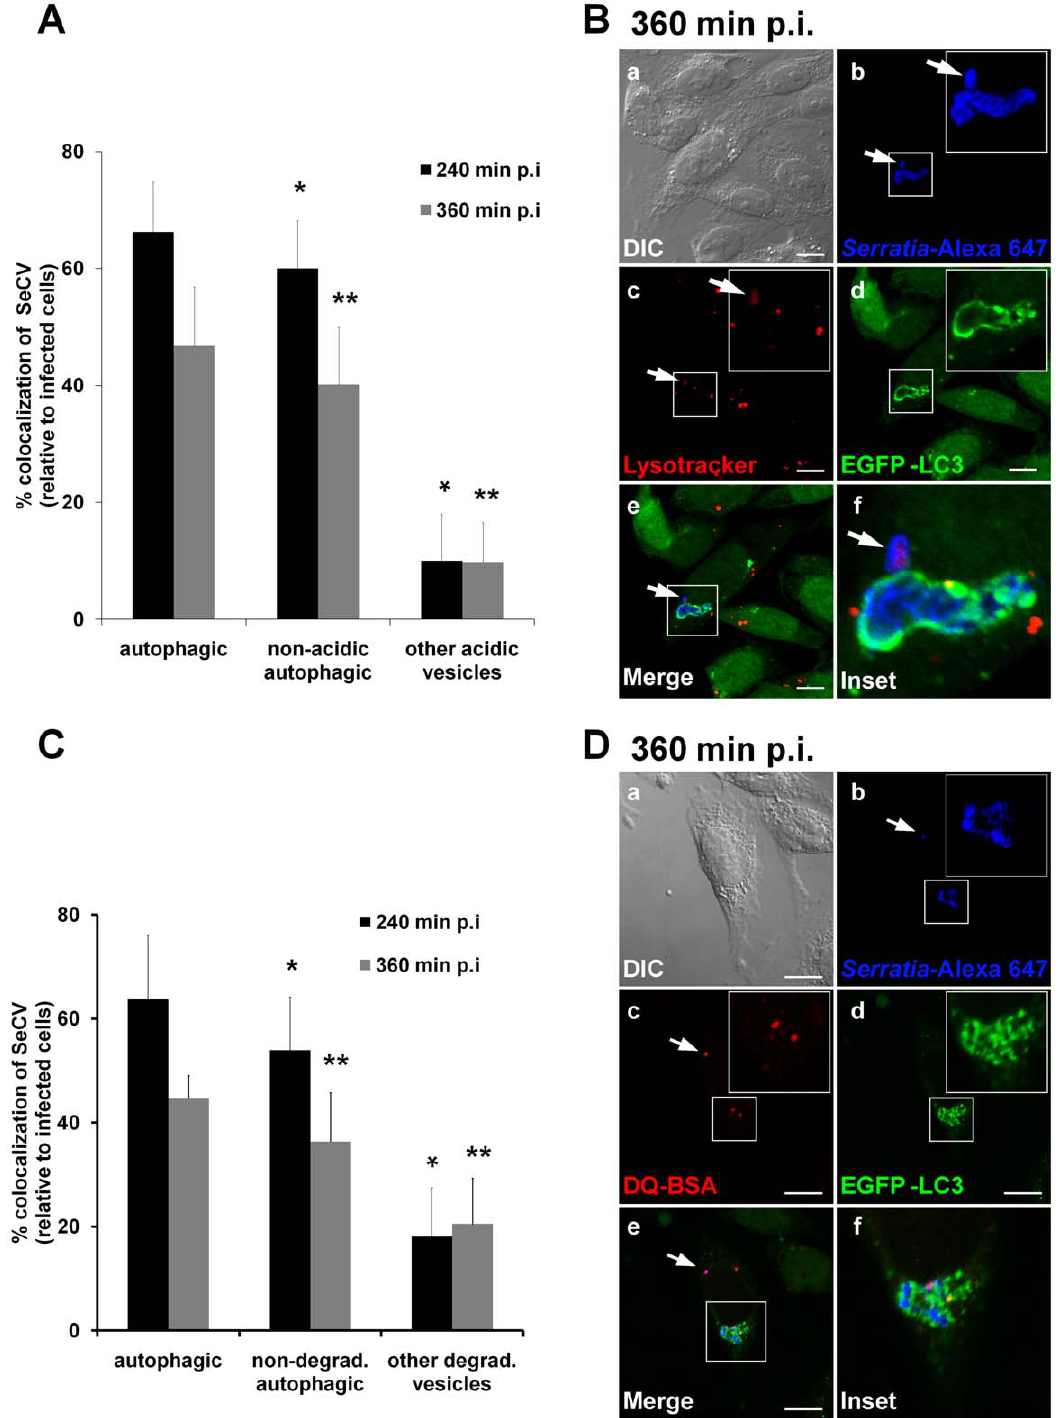
Figure 4. The S.marcescens -containing vacuoles are predominantly non acidic and non degradative compartments. A ) CHO-EGFP-LC3 cells were infected with wild-type S. marcescens. After 60 min p.i, cells were incubated with 3 m M of LysoTracker to label acidic compartments. Cells were fixed at 240 or 360 min p.i. and intracellular bacteria were detected with antibodies anti- Serratia coupled with a secondary antibody labeled with Alexa Fluor 647. The percentages of colocalization of bacteria with EGFP-LC3 and/or with Lysotracker were determined by fluorescence microscopy. At least 300 infected cells were counted for each condition. The average 6 S.D. is shown for two independent experiments, *and **p , 0.001. B ) Representative confocal laser captured images of CHO-EGFP-LC3 cells (green fluorescence, d) infected with S. marcescens (blue fluorescence, b) and incubated with Lysotracker (red fluorescence, c) at 360 min p.i. are shown. Inset image (f) shows higher magnification of the boxed area in the merged image (e), and highlights a non-acidic, autophagic SeCV. Arrows point at acidic vesicles. Bars: 10 m m. C) CHO-EGFP-LC3 cells were pre-incubated with 10 m g/ml of DQ-BSA for 4 hours to label degradative compartments. Subsequently, cells were infected with wild-type S. marcescens and fixed at 240 or 360 min p.i. Intracellular bacteria were detected with antibodies anti- Serratia coupled with a secondary antibody